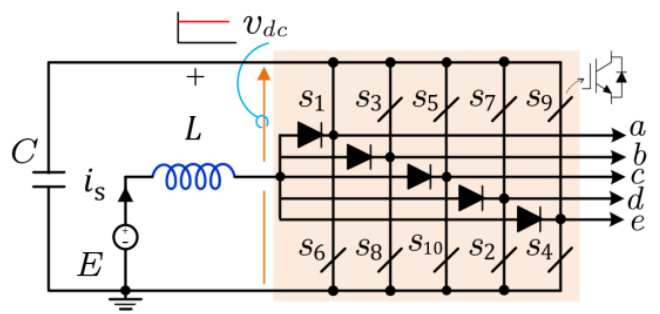
Figure 7. Five-phase SSI topology.